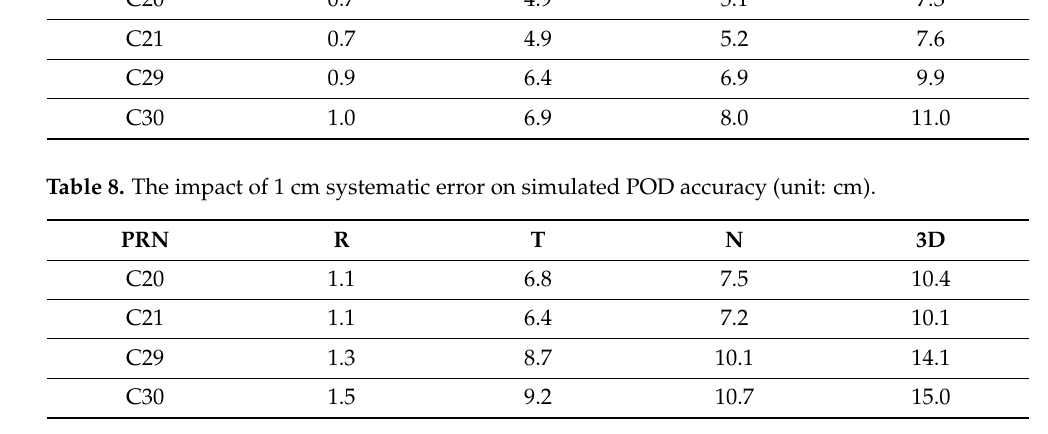
Table 8. The impact of 1 cm systematic error on simulated POD accuracy (unit: cm).